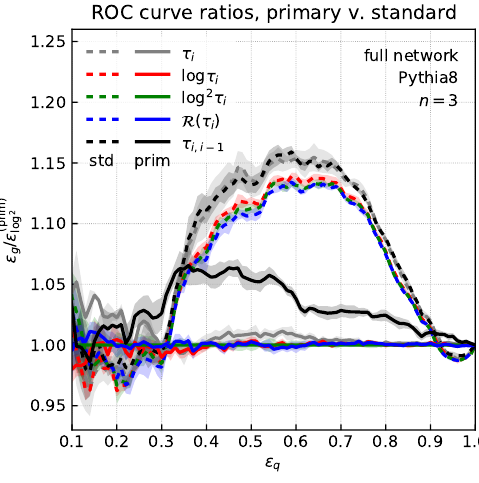
(a) Performance comparison between the stan- (b) Performance comparison between a single dard N -subjettiness (dashed lines) and the pri- perceptron (dashed lines) and a full neural net- mary N -subjettiness (solid lines). All results work (solid lines). All results are obtained using are obtained using a full neural network. primary N -subjettiness. Figure 6 . ROC curves obtained after training on a Pythia8 sample, using the N -subjettiness vari- ables, with n = 3. To better highlight di(cid:11)erences the vertical axes show the gluon rate normalised by what is obtained using log 2 T i inputs for primary N -subjettiness trained on a full neural network. The di(cid:11)erent colours correspond to di(cid:11)erent inputs to the neural